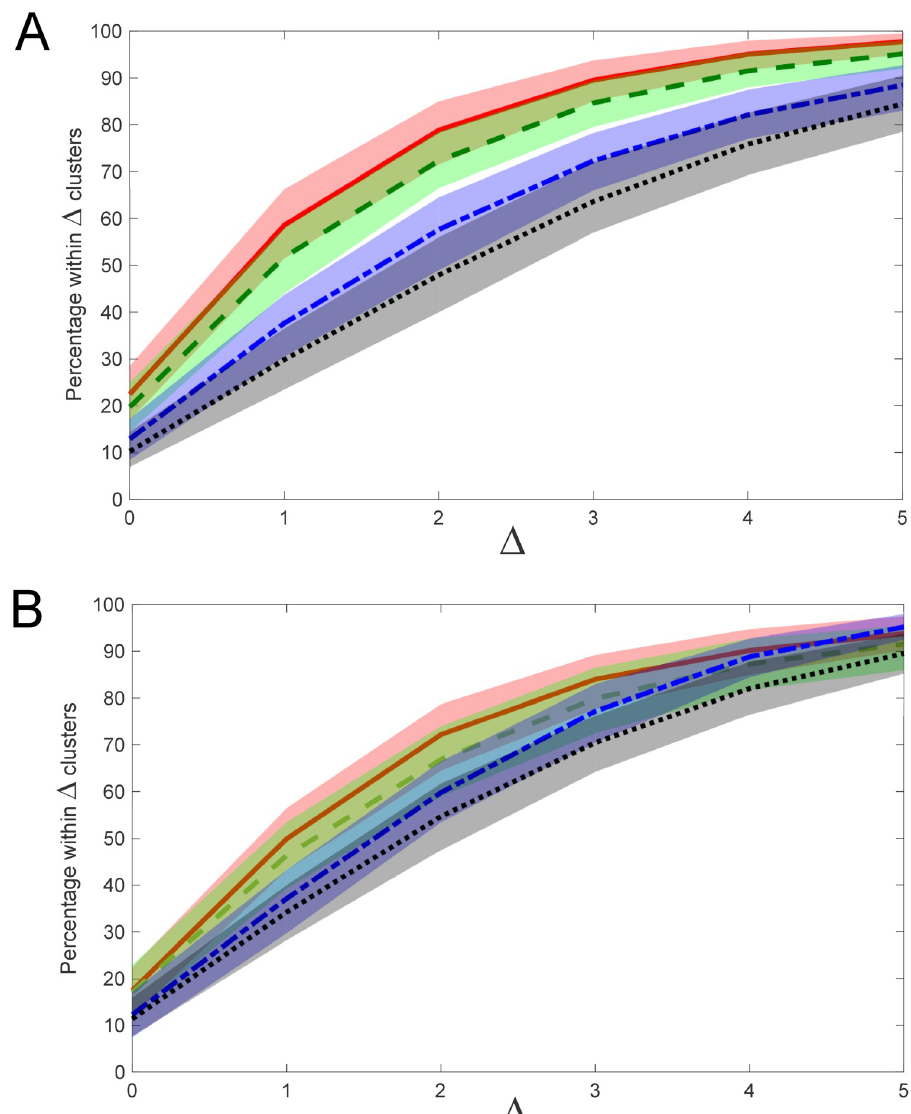
Fig 14. Effect of embedding dimension ( d ) on model performance. (A) Image data results; (B) Text data results. E Colour shaded regions represent 95% confidence interval with respect to mean percentage of model estimates lying within Δ clusters of the true cluster number (corresponding coloured line). Legend: solid RED, d = 50; segmented E GREEN, d E = 40 (image data); d E = 30 (text data); short-long segmented BLUE, d E = 10; dotted BLACK, d E = 2. Distance metric: L1 norm; histogram partitioning: R = 40. Dimensionality of image data: 40; dimensionality of text data: